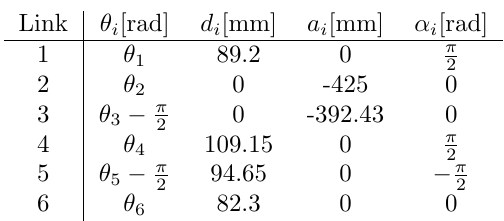
Table 1: DH-table for the Agilus R900 sixx robot